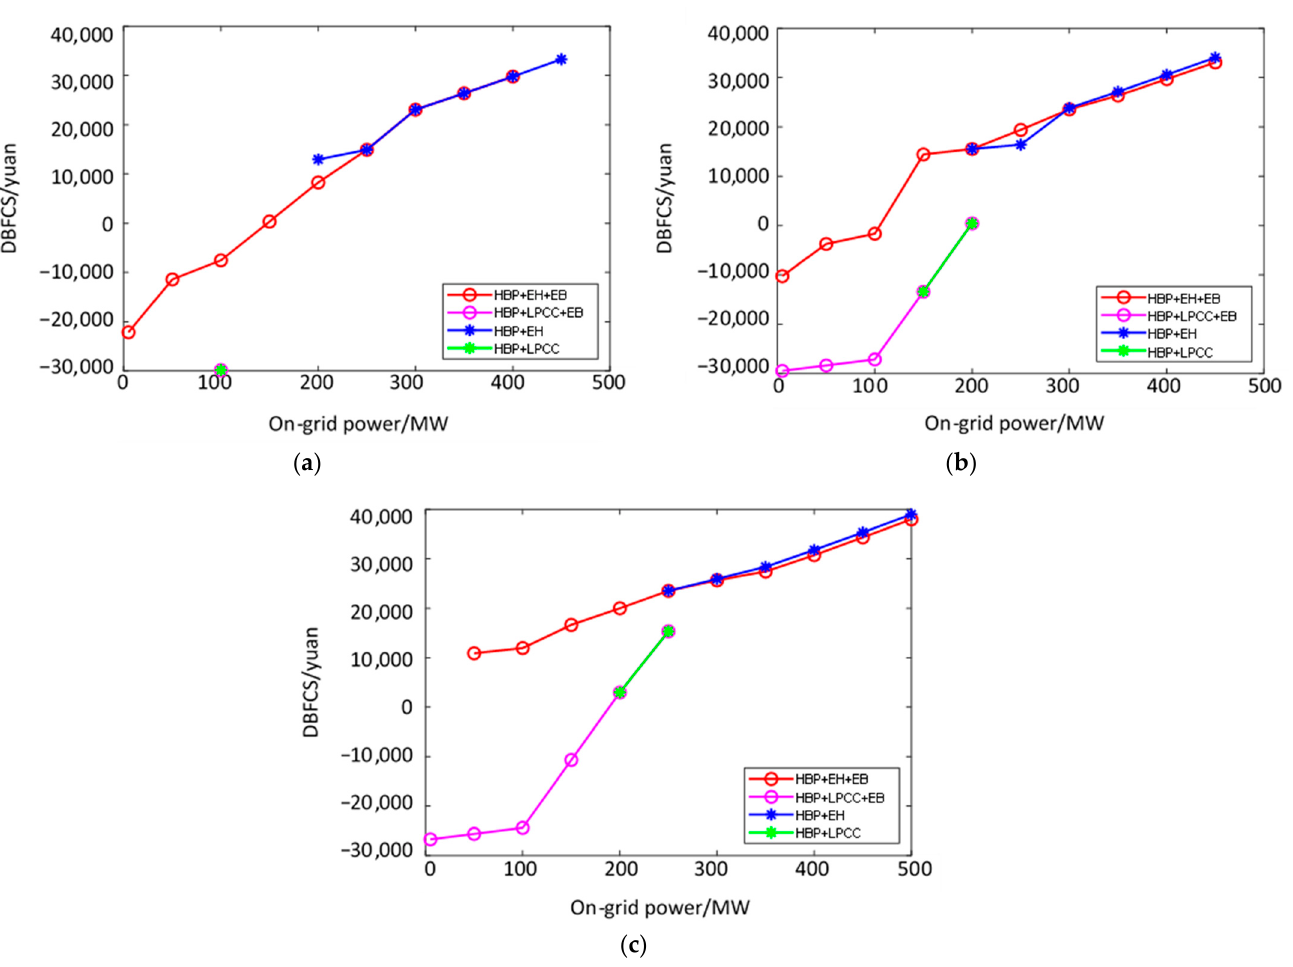
Figure 7. Simulation results aimed at minimizing energy supply costs. ( a ) Heat load 300 MW. ( b )